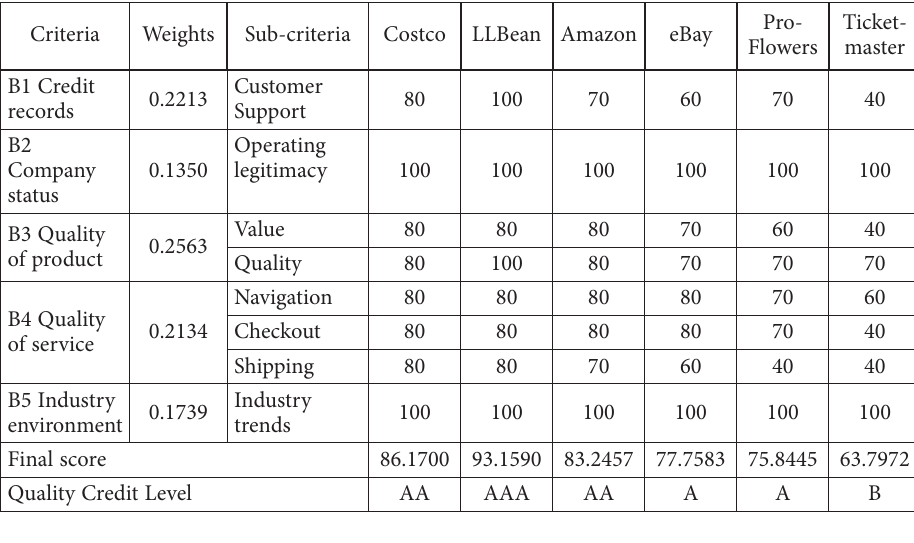
Table 15. Quality credit scores of six US companies